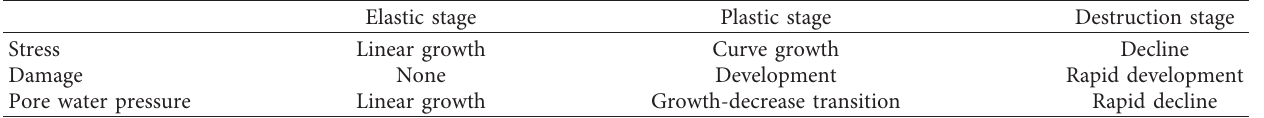
Table 1: The mode of “stress-injury-pore